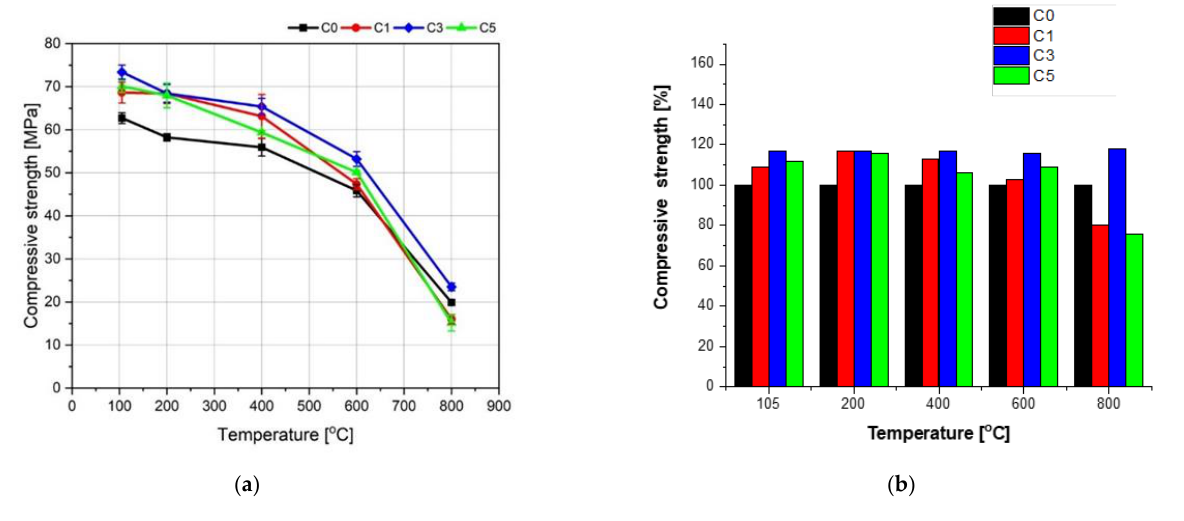
Figure 15. Influence of NS admixture on compressive strength as a function of heating temperature ( a ) and analysis of compressive strength changes for the concrete specimens containing NS in relation to the concrete C0 without NS ( b ).